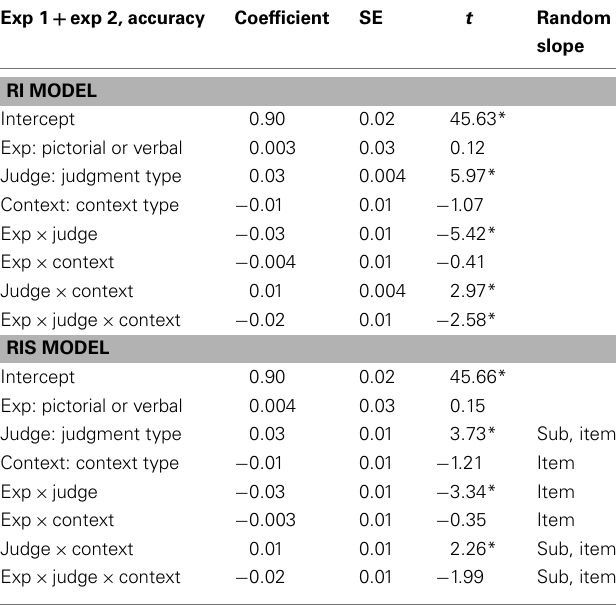
Table 4 |The linear mixed-effects regression models on the accuracies for the (picture and word)